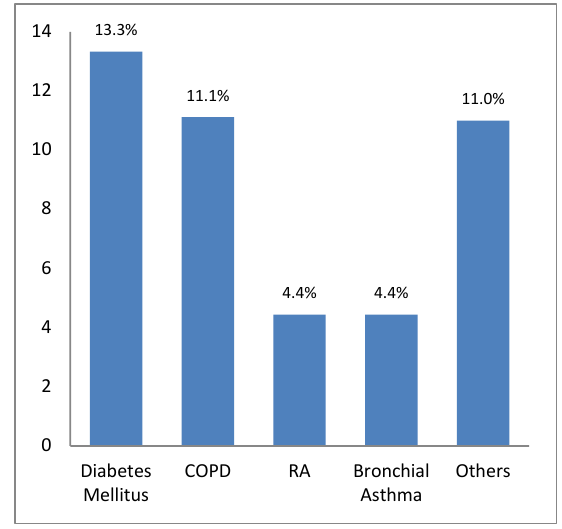
Figure 3 Common co-morbidities of patients in percentage Diabetes mellitus and COPD were common comorbidities in patients.